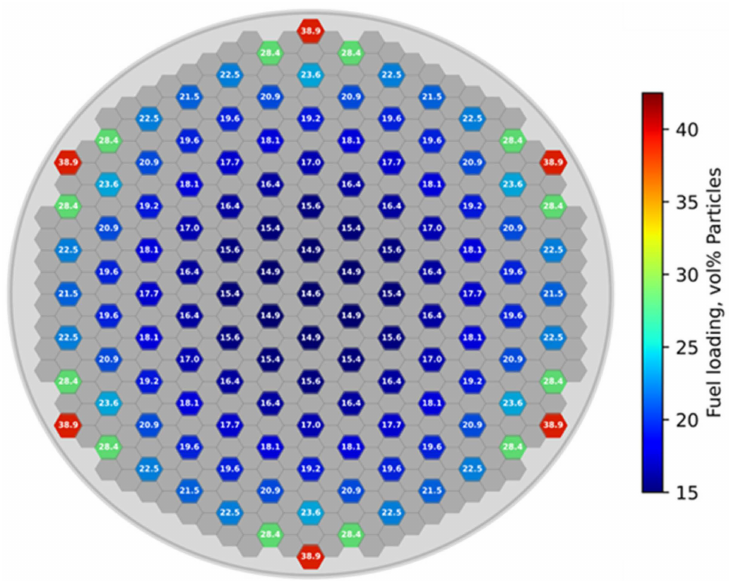
Figure 5. Fuel loading pattern.